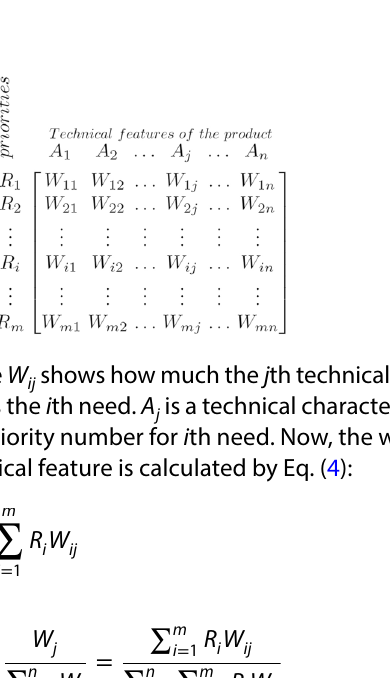
Fig. 3 Surface plot for fuzzy system